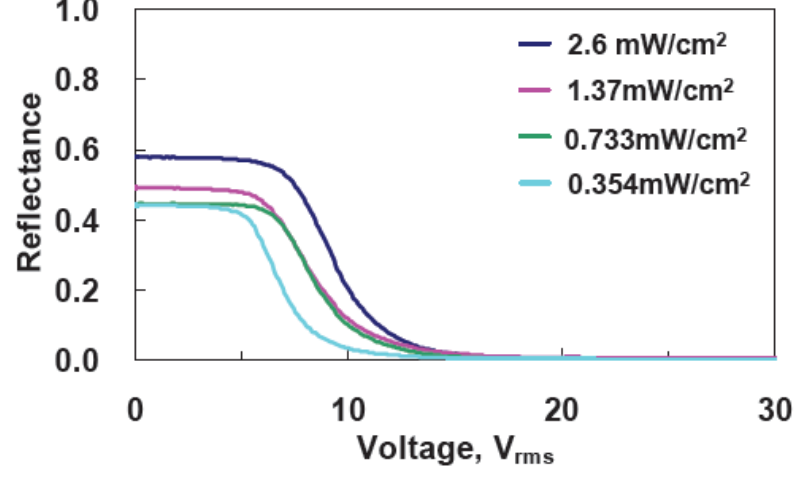
Figure 6. Voltage-dependent reflectance at various curing intensities at a curing temperature of 10